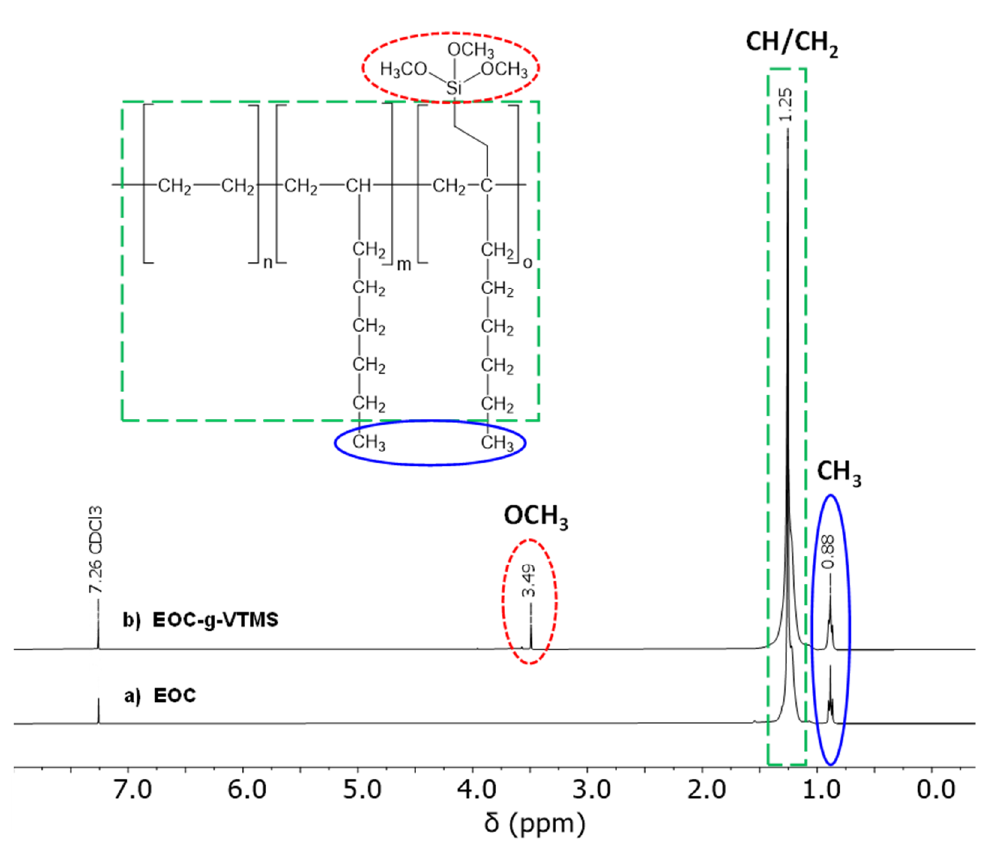
Figure 3. 1 H-NMR spectra of ( a ) raw unmodified EOC and ( b ) VTMS-grafted EOC (EOC-g-VTMS).